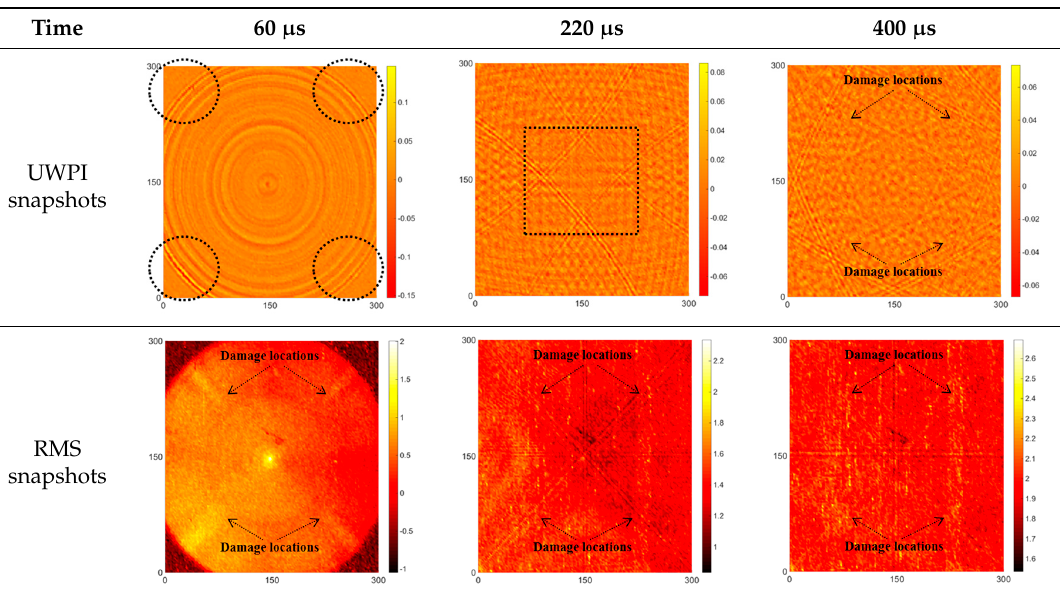
Table 7. UWPI and RMS snapshots of the back side of Specimen 2 at 60 μ s, 220 μ s and 400 μ s (the unit of x and y axis: mm).